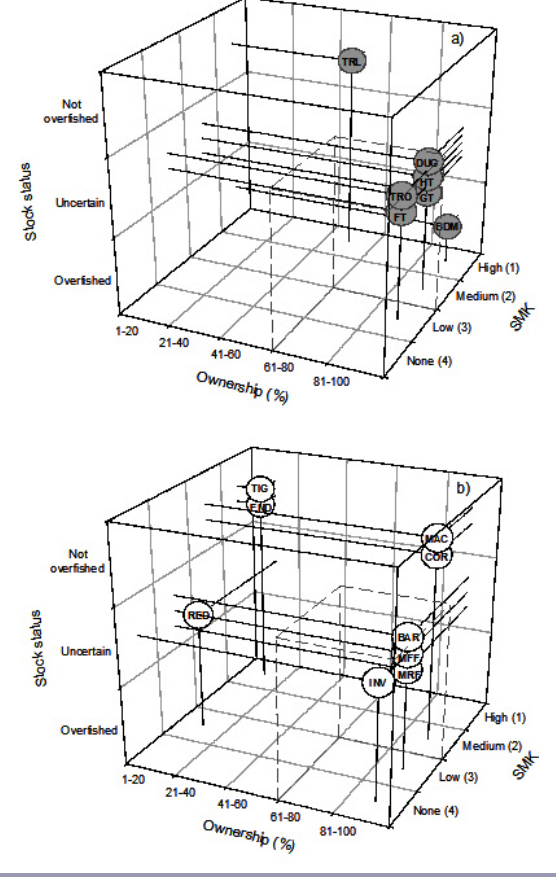
Fig. 3 . Fishery species or groups for which traditional ecological knowledge (TEK) a) was applied and b) was not applied relative to fishery ownership, stock status, and science and management knowledge (SMK). The dashed line box represents the status of the species for which TEK application could occur. Abbreviations are: green turtle ( Chelonia mydas ; GT), hawksbill turtle ( Eretmochelys imbricata ; HT), flatback turtle ( Chelonia depressa ; FT), dugong ( Dugong dugon ; DUG), trochus (TRO), bêche-de- mer (BDM), tropical rock lobster ( Panulirus ornatus ; TRL), mixed finfish (MFF), invertebrates (INV), coral trout ( Plectropomus leopardus ; COR), barramundi ( Lates calcarifer ; BAR), mixed reef fish (MRF), mackerel (MAC), blue endeavour prawns ( Metapenaeus endeavouri ; END), brown tiger prawns ( Penaeus esculentus ; TIG), and redspot king prawns ( Melicertus longistylus ; RED). Note that for ease of presentation, symbols have been separated where more than one species had the same stock status, e.g., GT, HT, DUG, and ownership (%) values have been categorized into intervals of 20% from data in Table